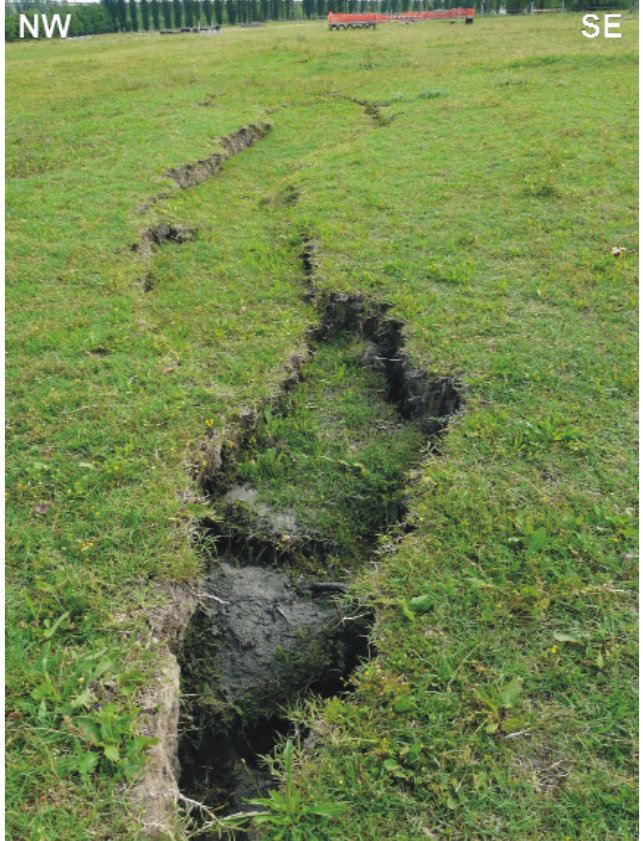
Figure 2. Example of a small-scale graben formed along the fracture sys- tem that developed on the levee of the paleo-reach of the Reno River, close to the trench site. See Figure 1 for location.